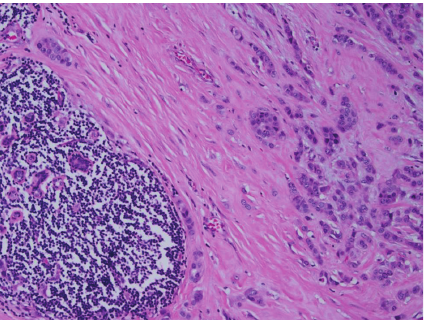
Figure 6: Infiltrating carcinoma cells, seen on the right side of the image, are present adjacent to an atypical lymphoid infiltrate consistent with chronic lymphocytic leukemia, present on the left side of the image (mastectomy specimen, hematoxylin & eosin stain, 100x